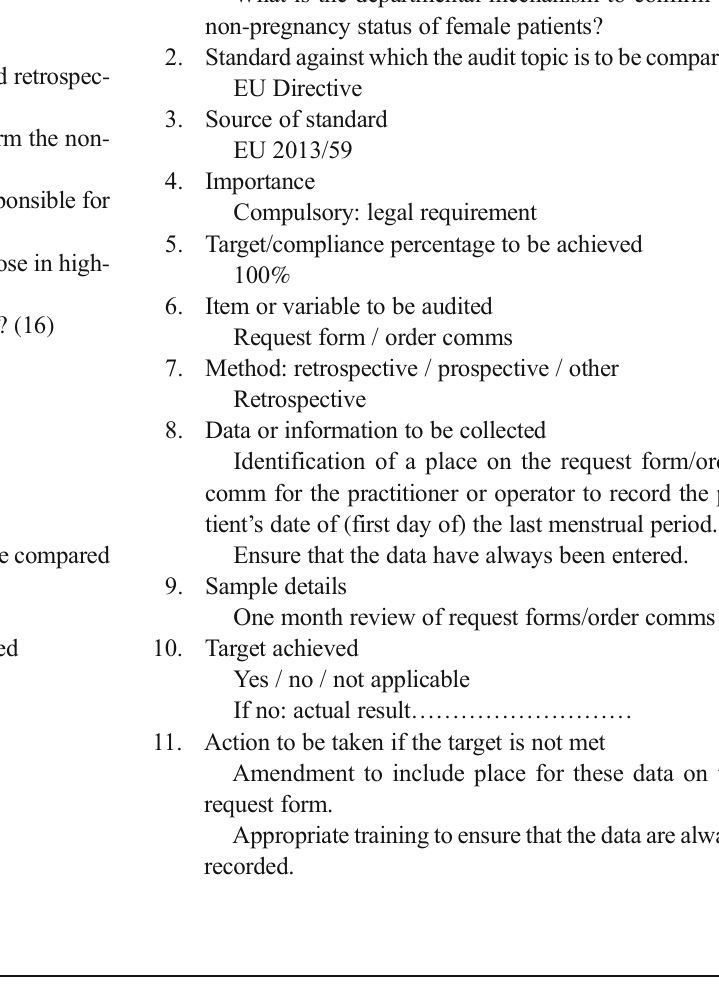
Summary of the Esperanto pilot project results Audit